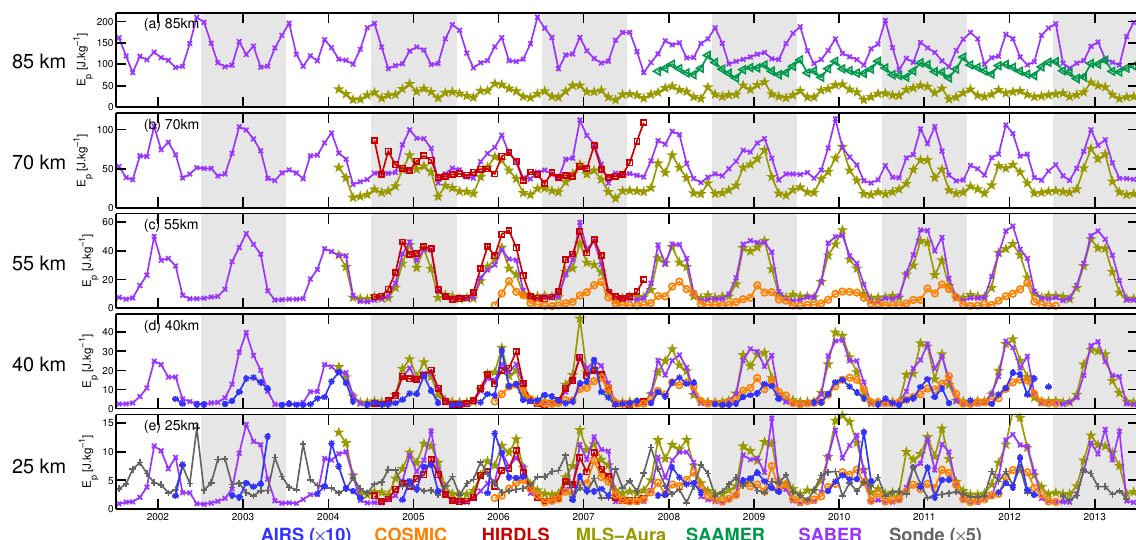
Figure 13. Time series from 2002–2013 of monthly-median observed GWPE for each of our